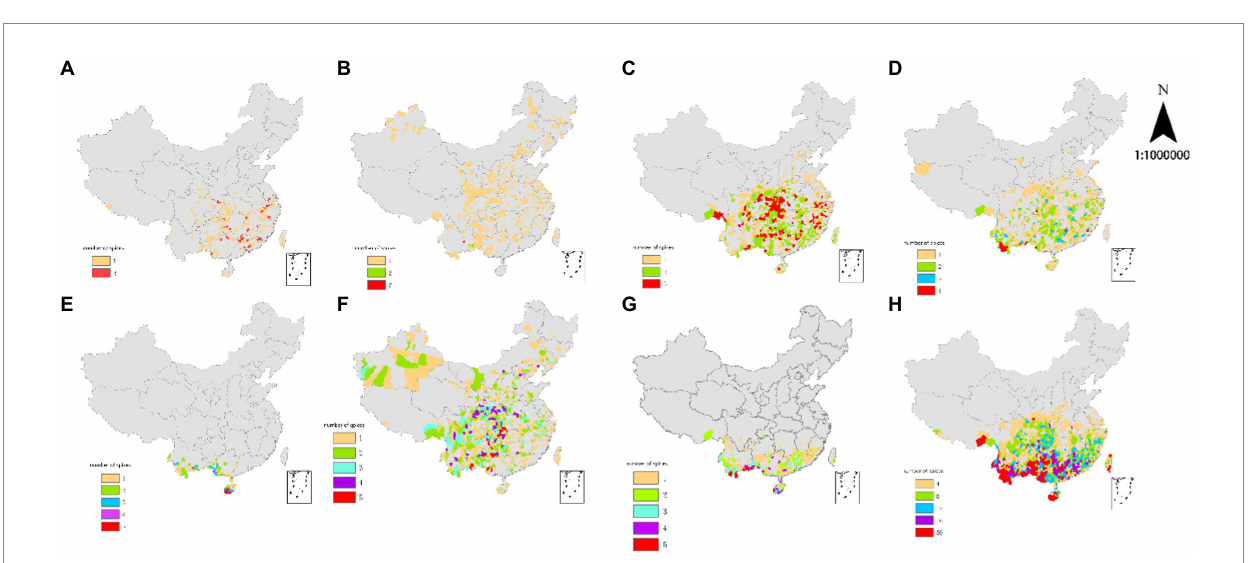
FIGURE 1 Spatial diversity distribution of every genus in the Moraceae in China. (A) Fatoua, (B) Humulus, (C) Broussonetia, (D) Cudrania (E) Streblus, (F) Morus, (G) Artocarpus, (H)